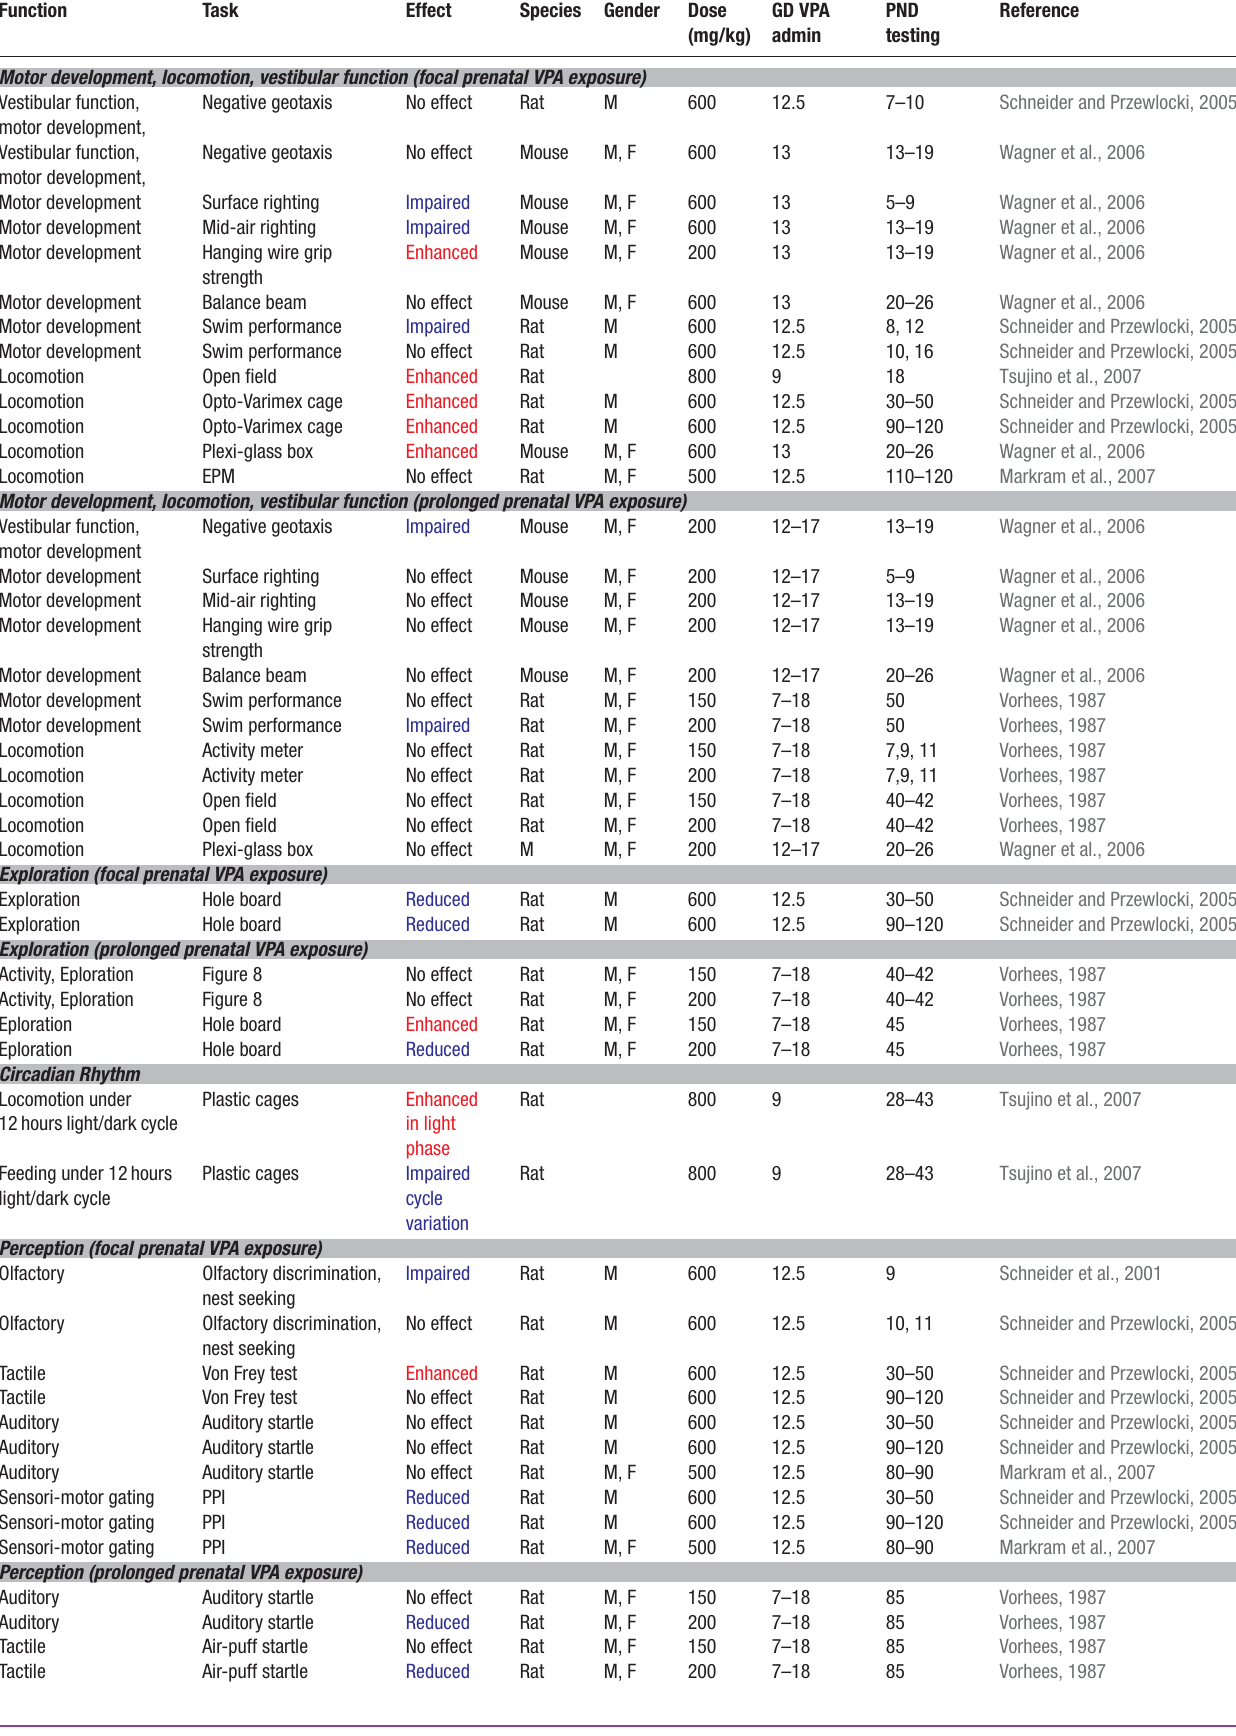
Table 4 . Behavioural alterations in the VPA rat model of